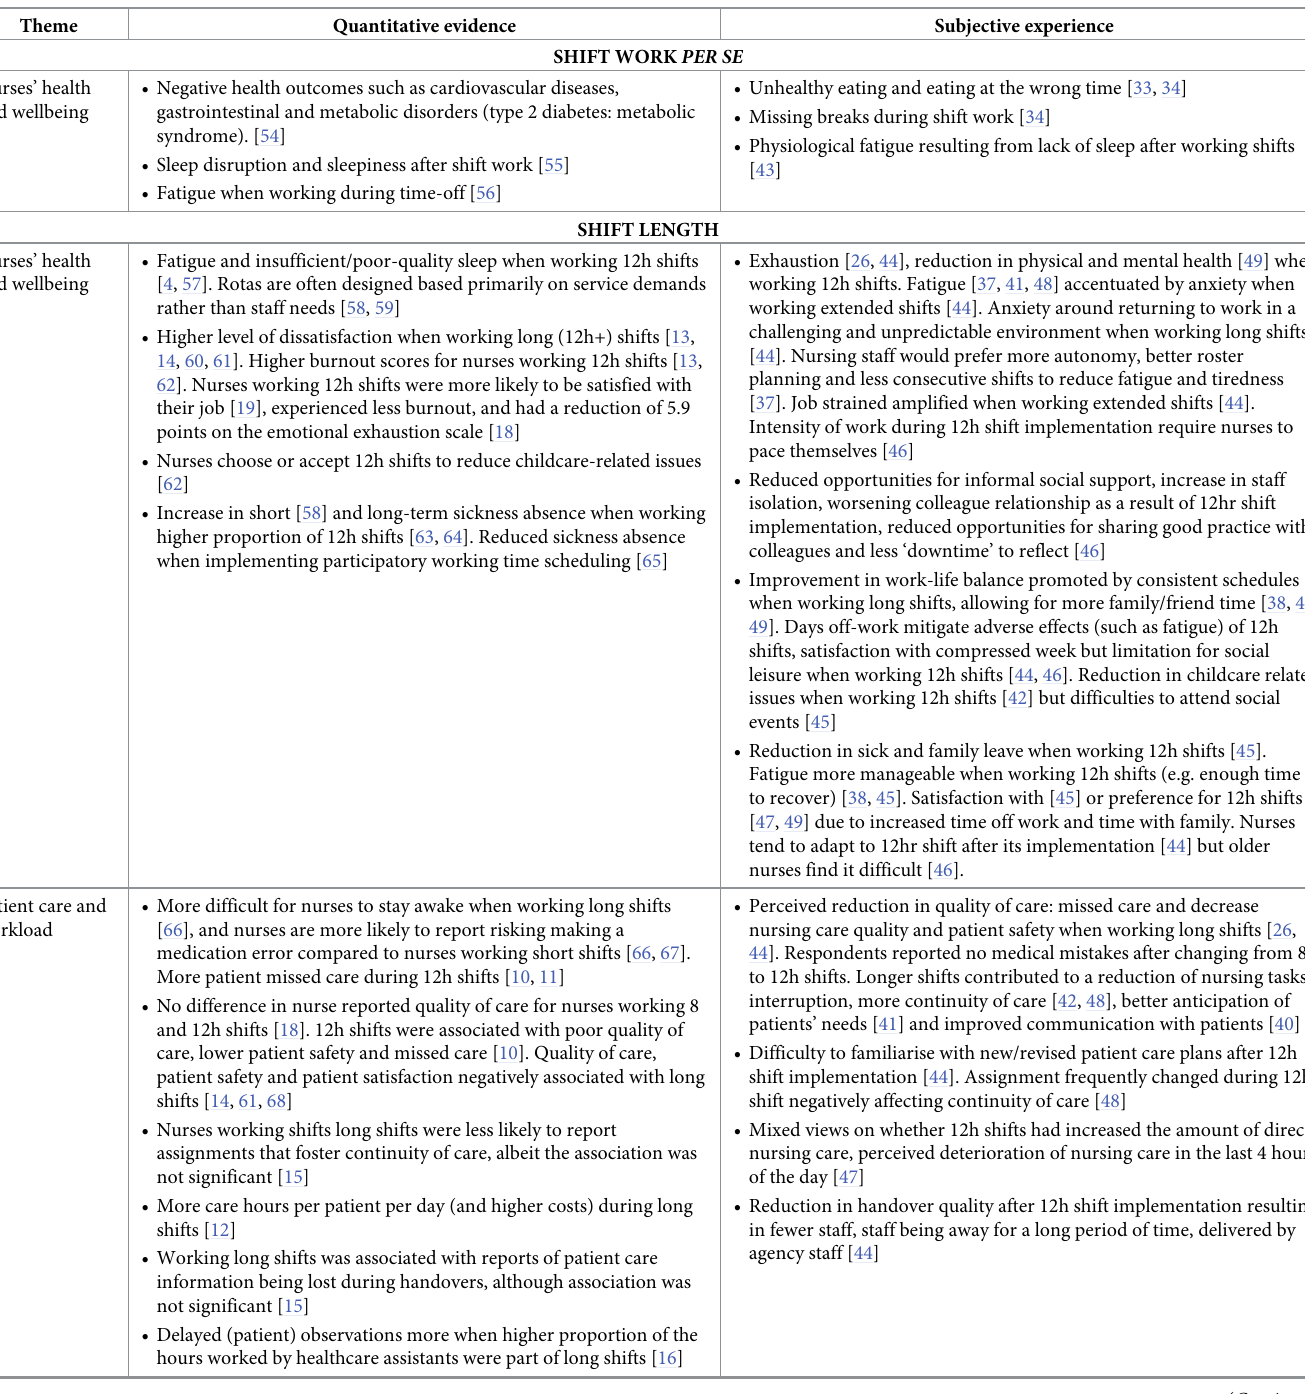
Table 3. Comparative table between subjective and quantitative evidence around nursing shift patterns.